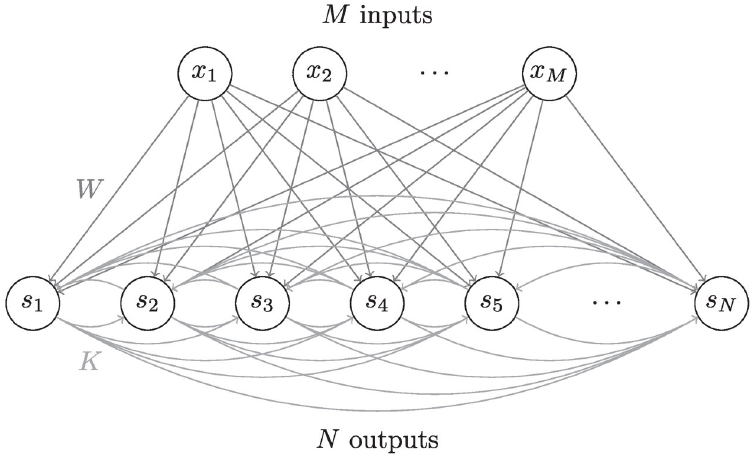
Fig 1. Network’s architecture. The architecture of an overcomplete recurrent neural network with M input neurons and N output neurons, where N > M .